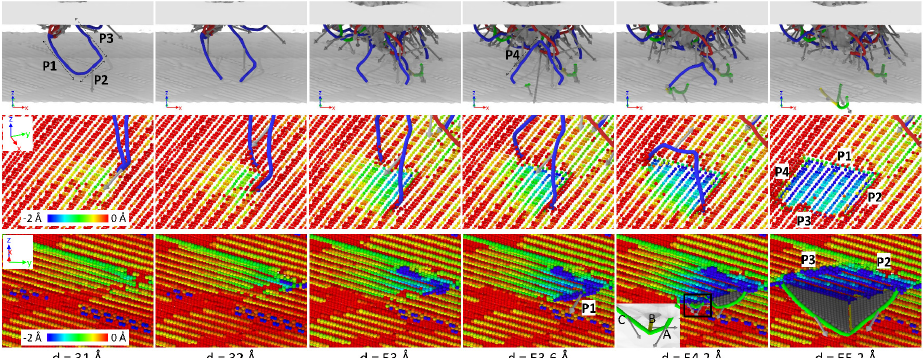
Figure 4. Interaction of dislocations generated by indentation of an Al/Si bicrystal to the depths d indicated with the interface. Dislocations are generated in the top Si layer which is crystallographically aligned with the bottom Al layer. P1–4 denote dislocation segments. Top row: dislocations generated (cid:104) 110 (cid:105) (dark blue), 1 (cid:104) 112 (cid:105) (green), 1 (cid:104) 100 (cid:105) in the Si top layer colored according to Burgers vector: 1 2 6 3 (yellow), and others (red). The gray planes indicate the surface, interface and the indent pit. Middle row: Close-up view of the penetrating dislocations and the Al interface atoms. Interface atoms are colored by height, see color bar. Bottom row: View from the Al side showing the Al interface atoms, the dislocations and the stacking faults. Insert at 54.2 Å zooms into rectangular area and demonstrates dislocation interaction, A+B=C, Equation (1). Figure taken from Ref. [22] with